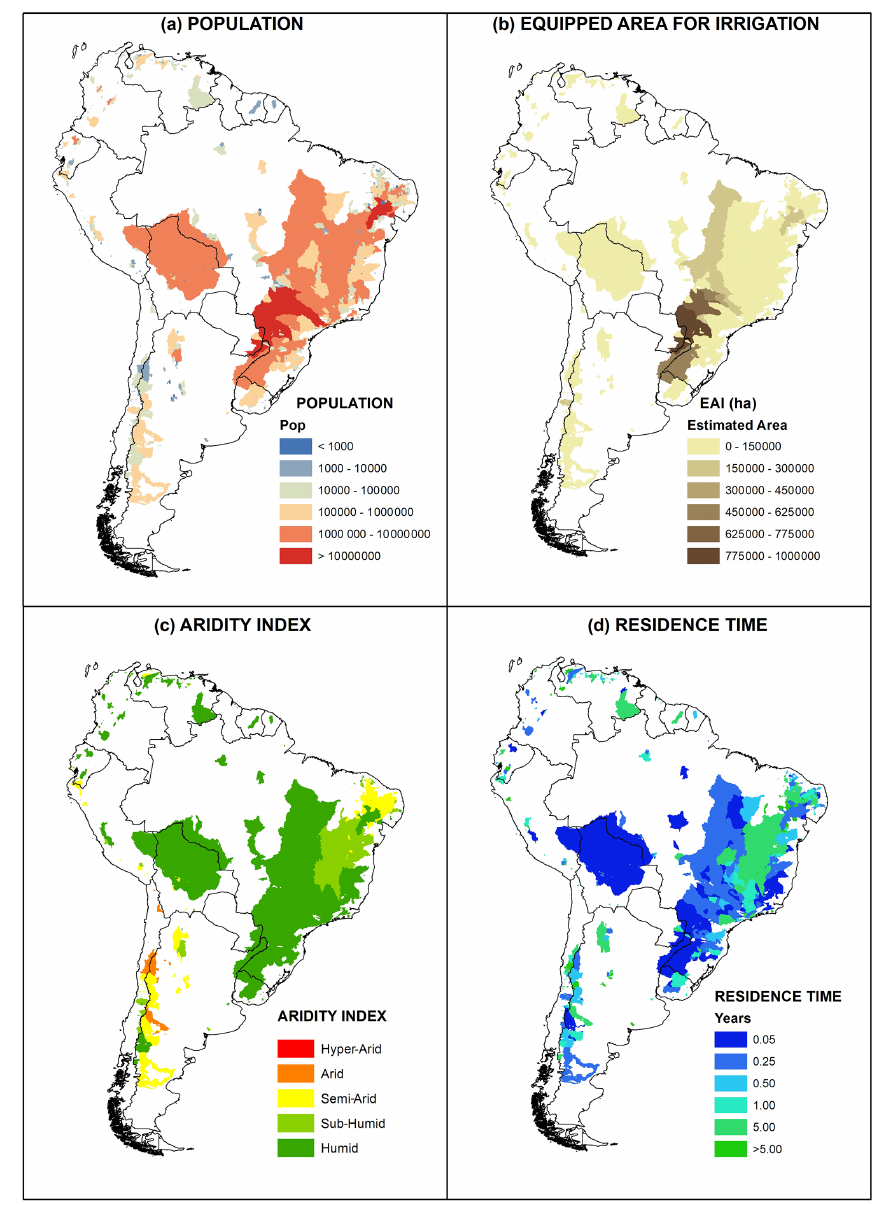
Figure 4. (a) Population, (b) equipped area for irrigation, (c) aridity index and (d) residence time for each dam’s